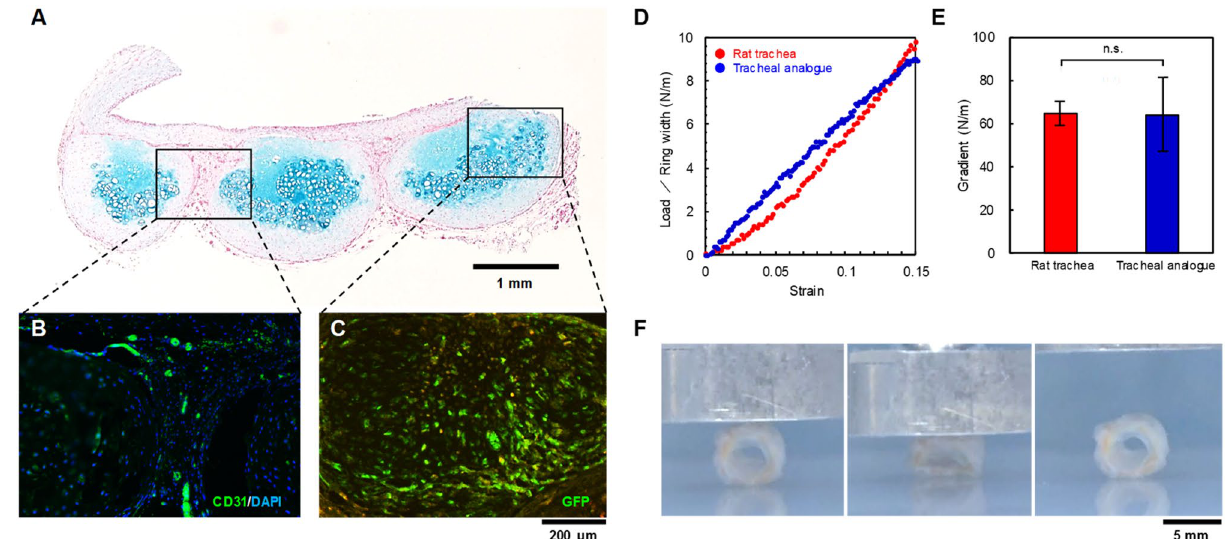
Figure 2. Histological analysis and mechanical properties of the tracheal analogues. The long-axis sections of the analogues stained with alcian blue dye for the cartilage proteoglycans ( A ), CD31 antibody for the capillary vessels and DAPI for the nucleus ( B ), and GFP for cell tracing ( C ). Typical examples of deformation curves of the tracheal analogue and rat native trachea ( D ). The gradients of load-strain curves in 0.05 ~ 0.1 strain range for the tracheal analogue ( n = 5) or rat native trachea ( n = 3) ( E ). Sequential photographs of the deformation and repair of tracheal analogue ( F ).